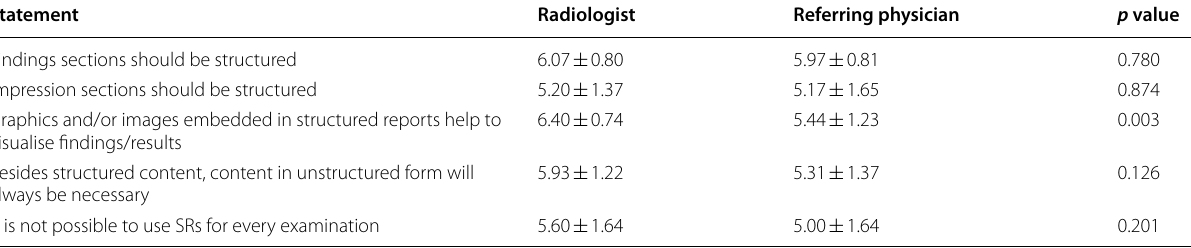
Table 3 Ratings of the statements (referring physicians vs. radiologists, 7-point-